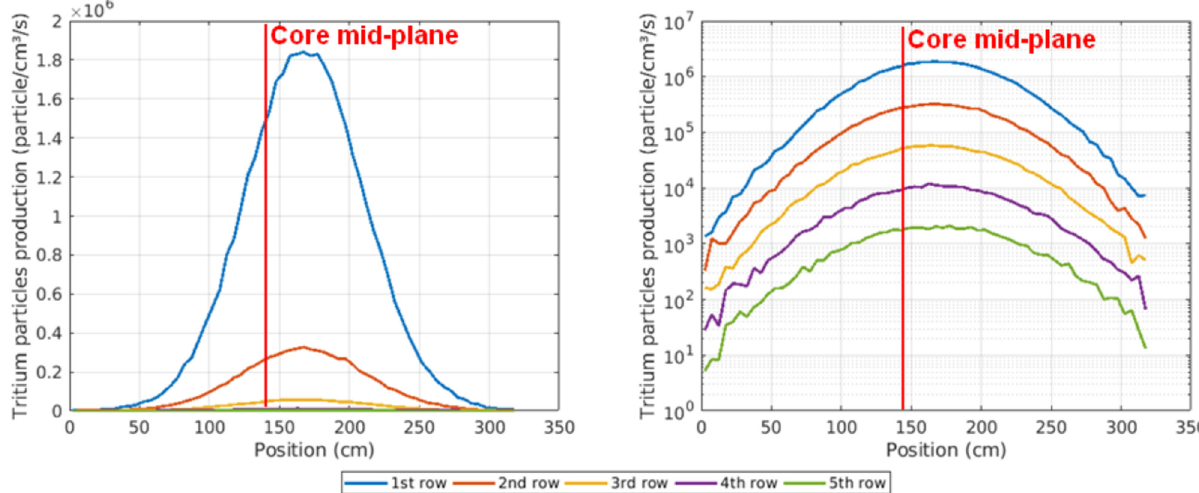
Fig. 20. Axial traverses of the production of tritium particles in the neutron shielding, linear scale (left), logarithmic scale